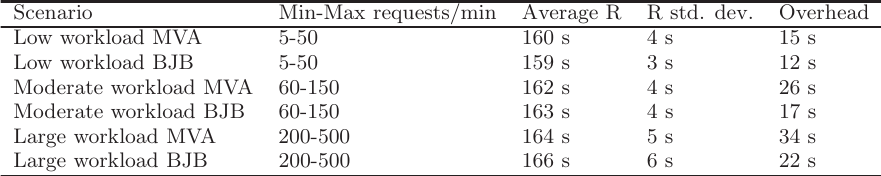
Table 3: Time and configuration results obtained with the scientific benchmark Scenario